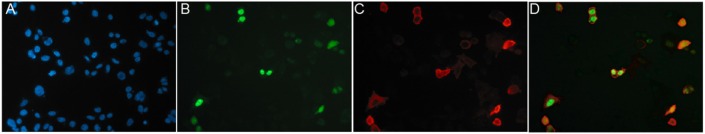
Identification of specific binders using CHO cells transiently co-transfected with expression vectors for the membrane protein of interest and nuclear GFP. CHO cells were transiently co-transfected with expression vectors for GFP fused to a nuclear localization sequence and the cDNA expression vector used for immunization, in this case encoding the homotrimeric ligand-gated P2X7 ion channel. Cells plated onto 96-well plates were analyzed 24 h after transfection by immunofluorescence microscopy. Green nuclei clearly distinguish transfected CHO cells from untransfectd CHO cells (blue nuclei stained with the DNA-binding dye Hoechst 33342). Cells were screened for cell surface binding of specific antibodies and bound antibodies were detected with a phycoerythrin (PE)-conjugated secondary antibody. (A) Hoechst dye, (B) GFP, (C) PE, and (D) merged images. Reprinted from Cellular Immunology 236, Sahil Adriouch, Gudrun Dubberke, Philip Diessenbacher, François Rassendren, Michel Seman, Friedrich Haag, Friedrich Koch-Nolte, Probing the expression and function of the P2X7 purinoceptor with antibodies raised by genetic immunization, 72–77, ©2005, with permission from Elsevier.